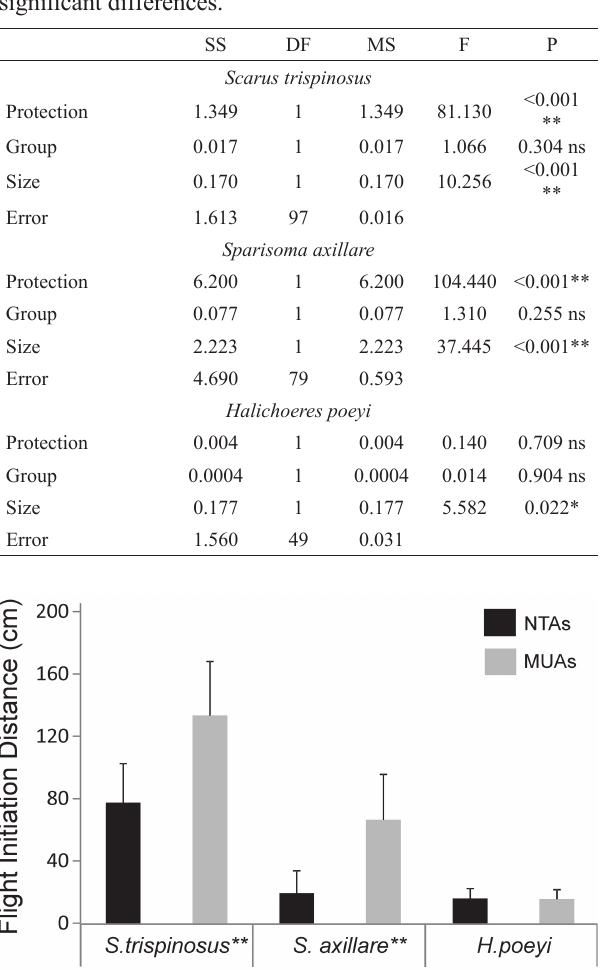
Table 1 . Analysis of covariance (ANCOVA) output showing